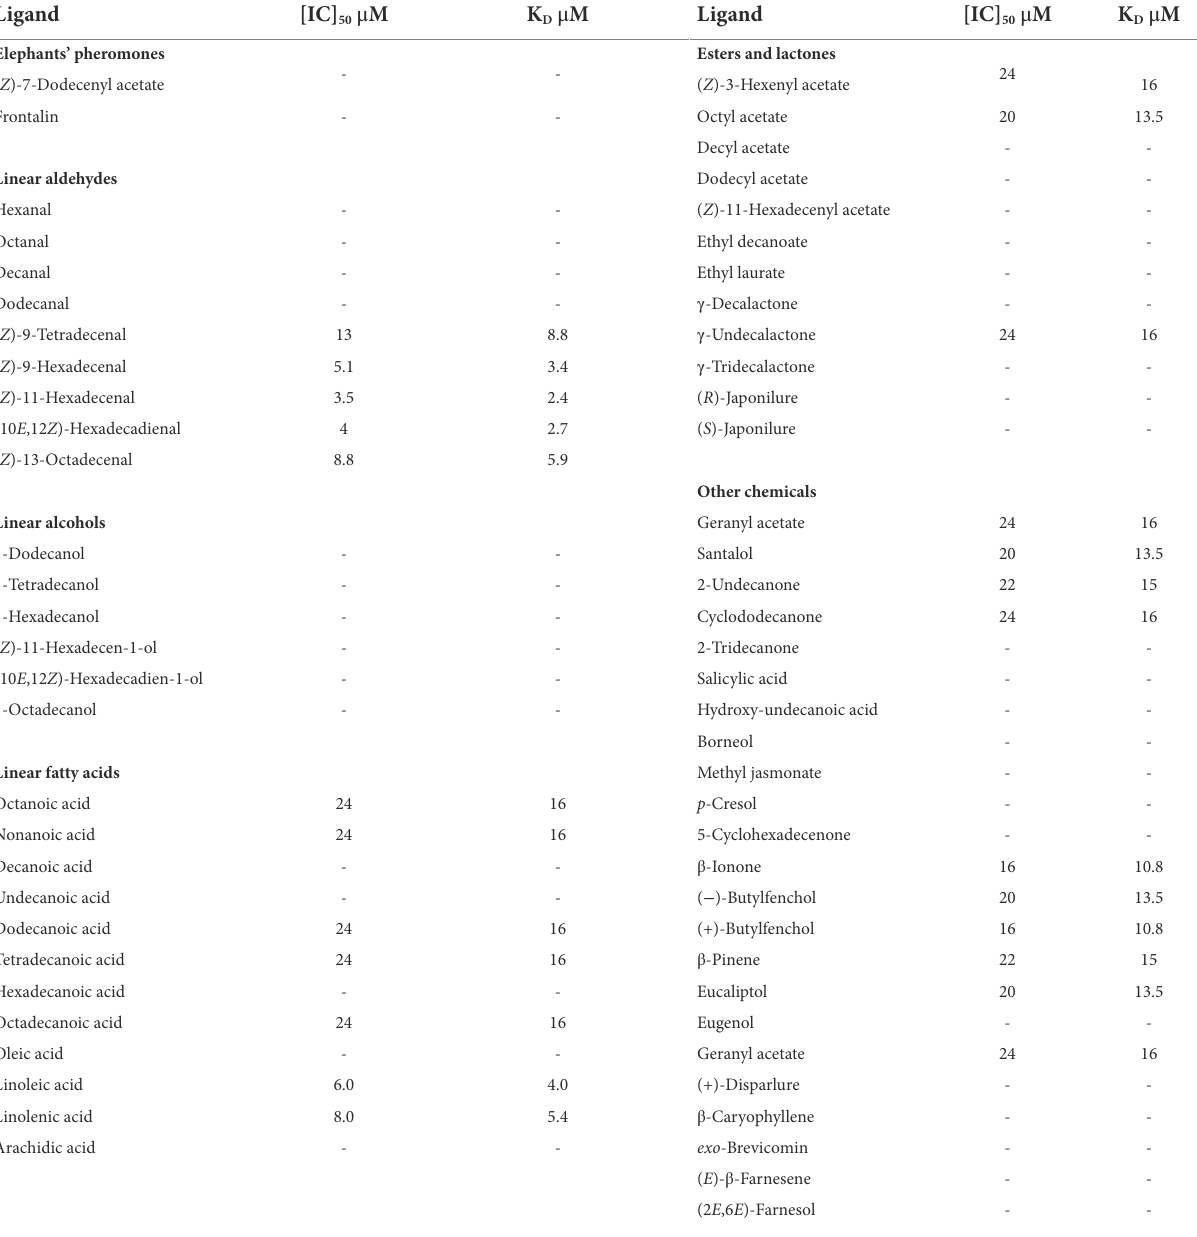
Values of [IC] 50 greater than 16 μ M were